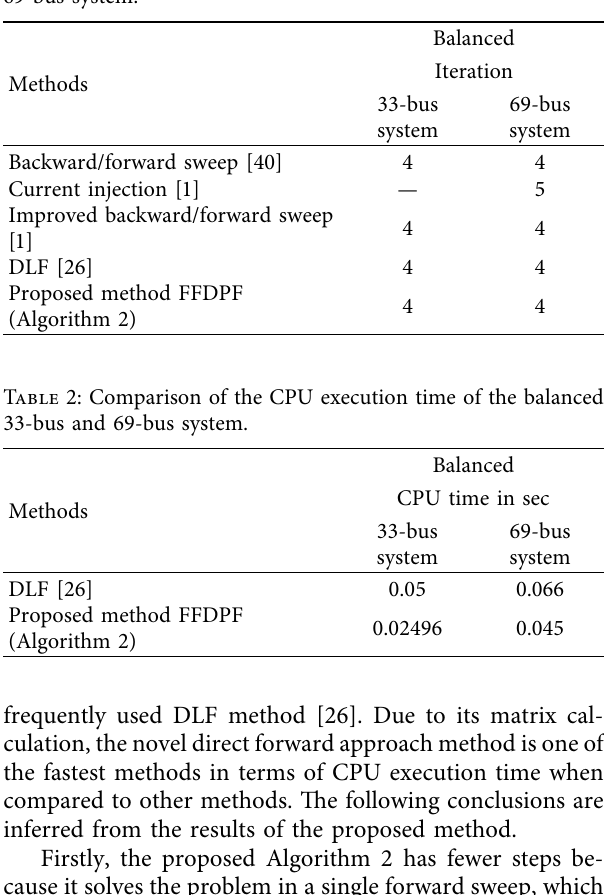
Figure 6: Te magnitude of the radial and weakly meshed system voltages: (a) 33-bus and (b) 69-bus. Table 1: Comparison of iterations of the balanced 33-bus and 69-bus system.